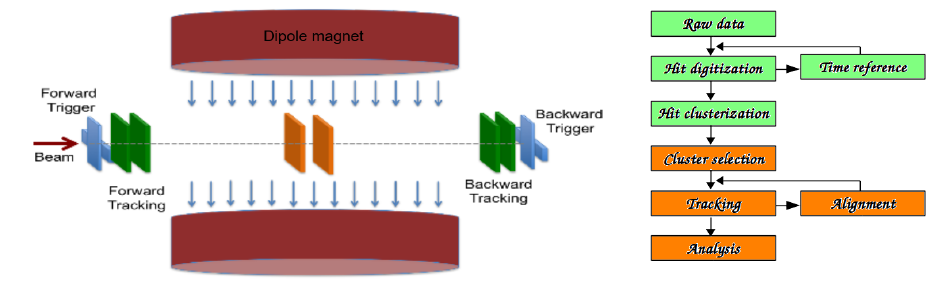
Figure 1: On the left, a scheme of a general testbeam experiment setup: six triple-GEM detectors are shown, where the two in the middle are the detectors under test and the other four are used as a tracking system. On the beam line and in the external region there are the scintillating bars used in the trigger system. The figure includes also the sketch of a dipole magnet around the test detectors. On the right, a diagram summarizes the flow in the code from the basic information of the hit and the cluster to the detector performance after tracking and alignment. The di ff erent colours separate the two parts of the code described in the text.